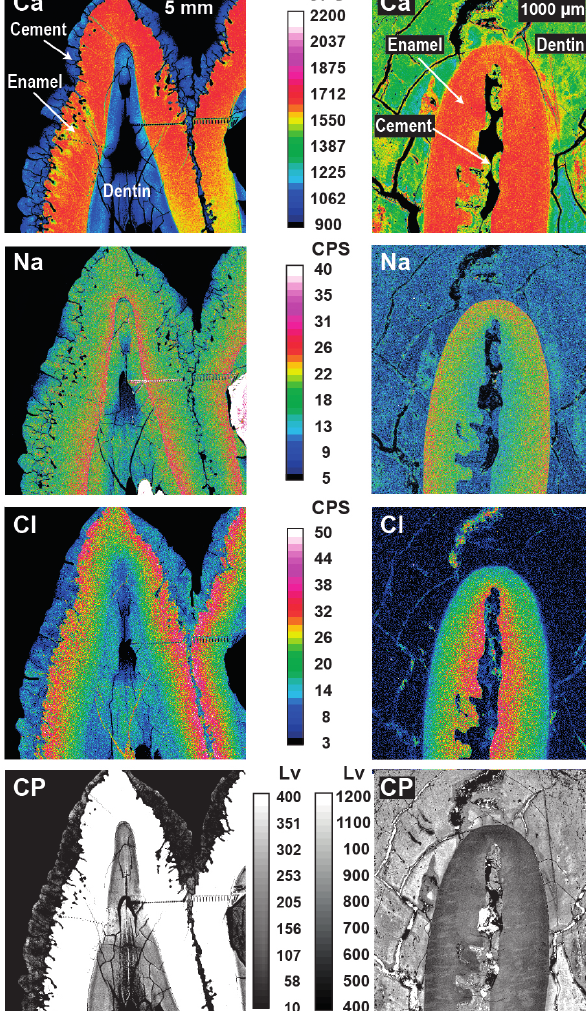
Fig. 2. Element maps for Ca, Na, Cl and backscattered images (CP) of modern (sample S276, molar M3; left row) and fossil (sam- ple 5306, molar frag.; right row) Hippopotamid teeth. Note the significantly higher Ca intensities in enamel compared to that in dentin and cement, which reflects lower porosity and higher Ca con- centrations in enamel. Variation of Ca along an apex-cervix profile reflects differences in mineral density. The zonal distribution of Cl and Na in enamel reflects concentration variation. Note the contrast- ing brightness levels (CP) in modern and fossil enamel and dentin. Modern dentin has a low average atomic number (low Z ) compared to enamel. Intensities are reversed in fossil materials.